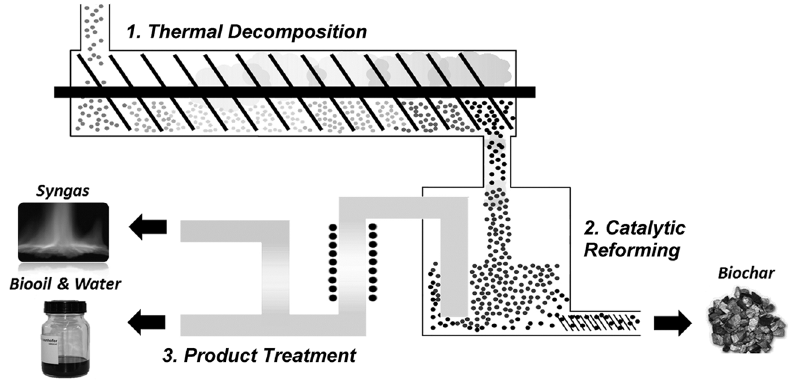
Fig. 6. – Thermo-Catalytic Reforming process overview (adapted from http://www. susteen-tech.com/technology.html ). 1) Thermal Decomposition: biomass is carbonised to biochar at intermediate temperatures and volatile organic compounds are extracted. 2) Cat- alytic Reforming: the biochar is heated up to 600–750 ◦ C and brought in contact with the volatile compounds. 3) Product Treatment: volatile compounds are condensed and the product syngas is cleaned for particles and aerosols in a relatively simple product treatment